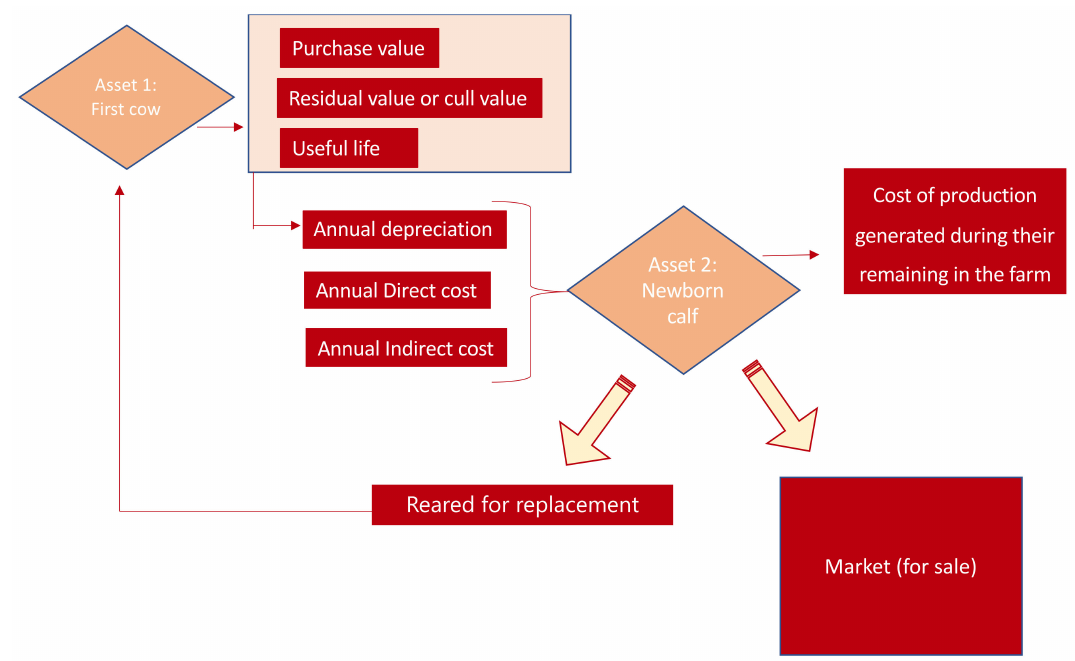
Figure 1. Model for estimation of cost of